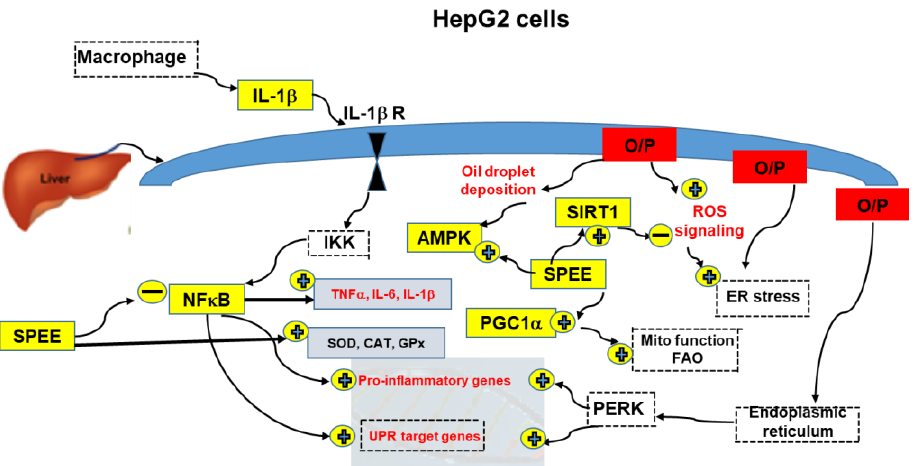
Figure 9. O/P insults HepG2 cell to induce ROS signaling via ER stress associated with oil droplet deposition, which enhances energy stress and upregulates AMPK, Sirt1 and, subsequently, PGC1- α . SPEE further upregulates AMPK, Sirt1 and PGC1- α . Simultaneously, O/P stimulates macrophage to produce IL-1 β , which activates NF κ B to upregulate antioxidant and pro-inflammatory cytokines TNF- α , IL-6 and IL-1 β . On the other hand, O/P may upregulate PERK which in turn upregulates the pro-inflammatory genes and UPR target genes. SPEE downregulated pro-inflammatory cytokines; conversely, it upregulated the antioxidant enzymes’ activities. Finally, the upregulated PGC1- α im- proved the mitochondrial function (Mito function) and fatty acid oxidation (FAO). Items with dotted lines and dotted boxes are depicted from the literature and were not included in this